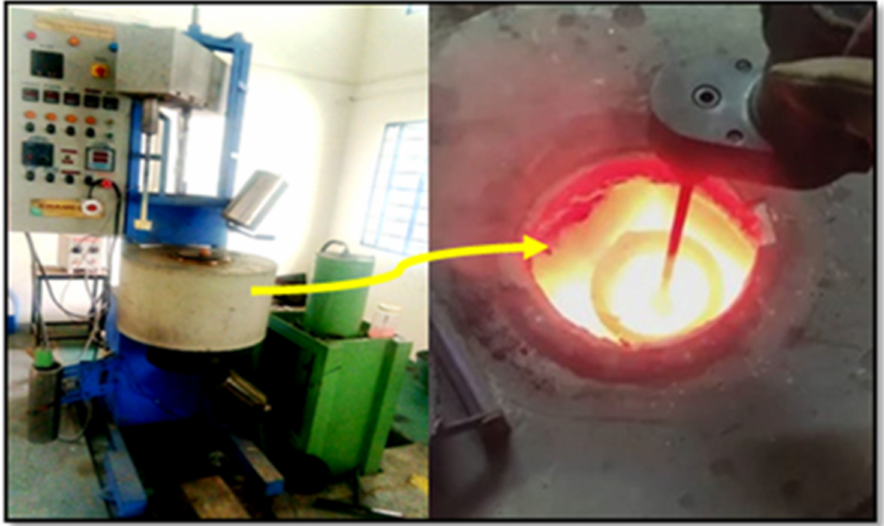
Figure 1. Stir casting process